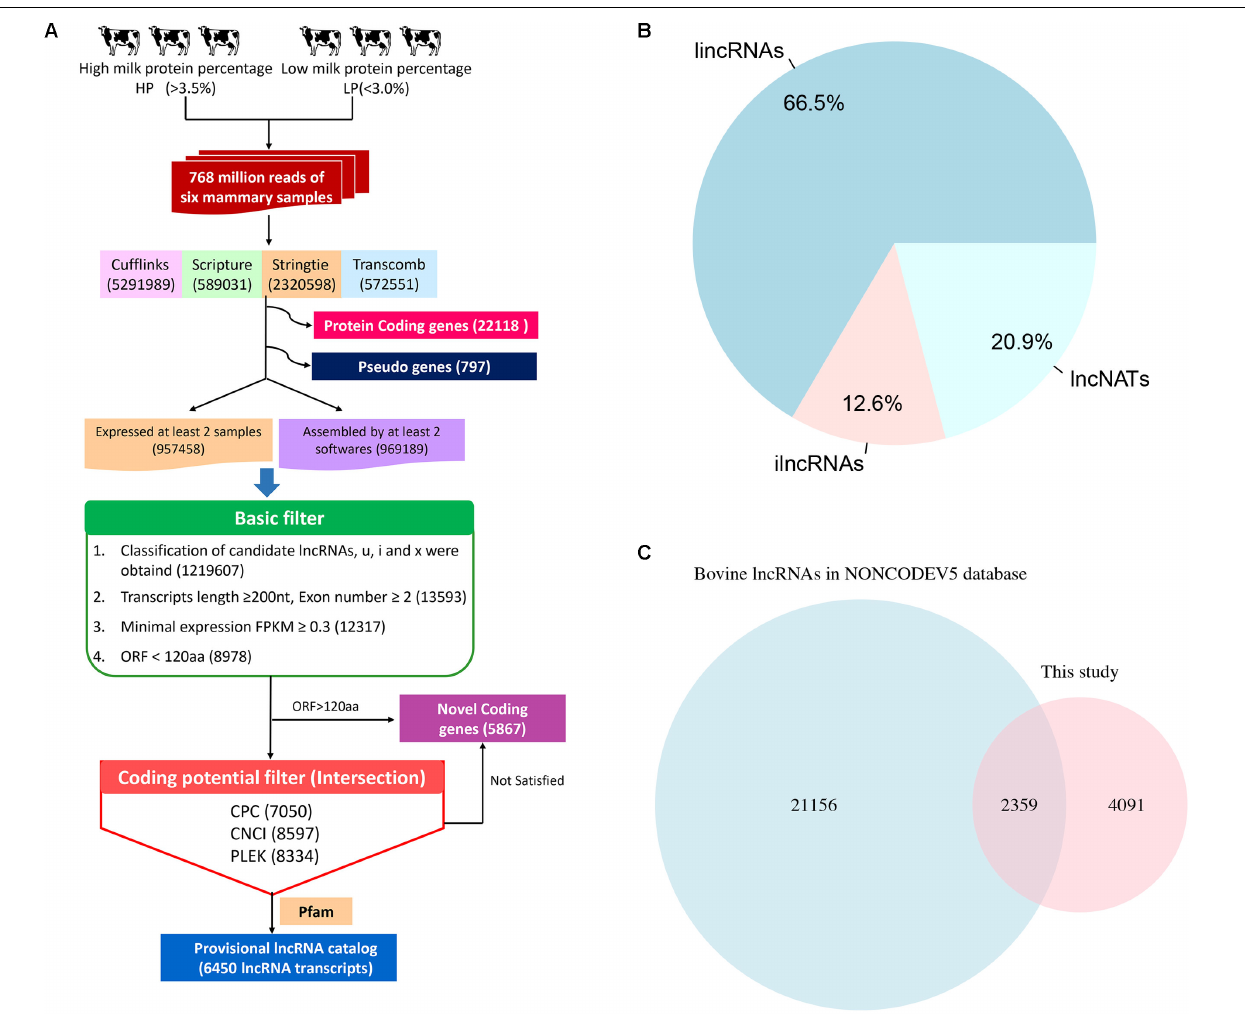
FIGURE 1 | The computational pipeline used to identify lncRNA genes from RNA-seq data. (A) The pipeline of lncRNA identification. (B) The category of lncRNAs. (C) The result of lncRNAs overlapping with NONCODE